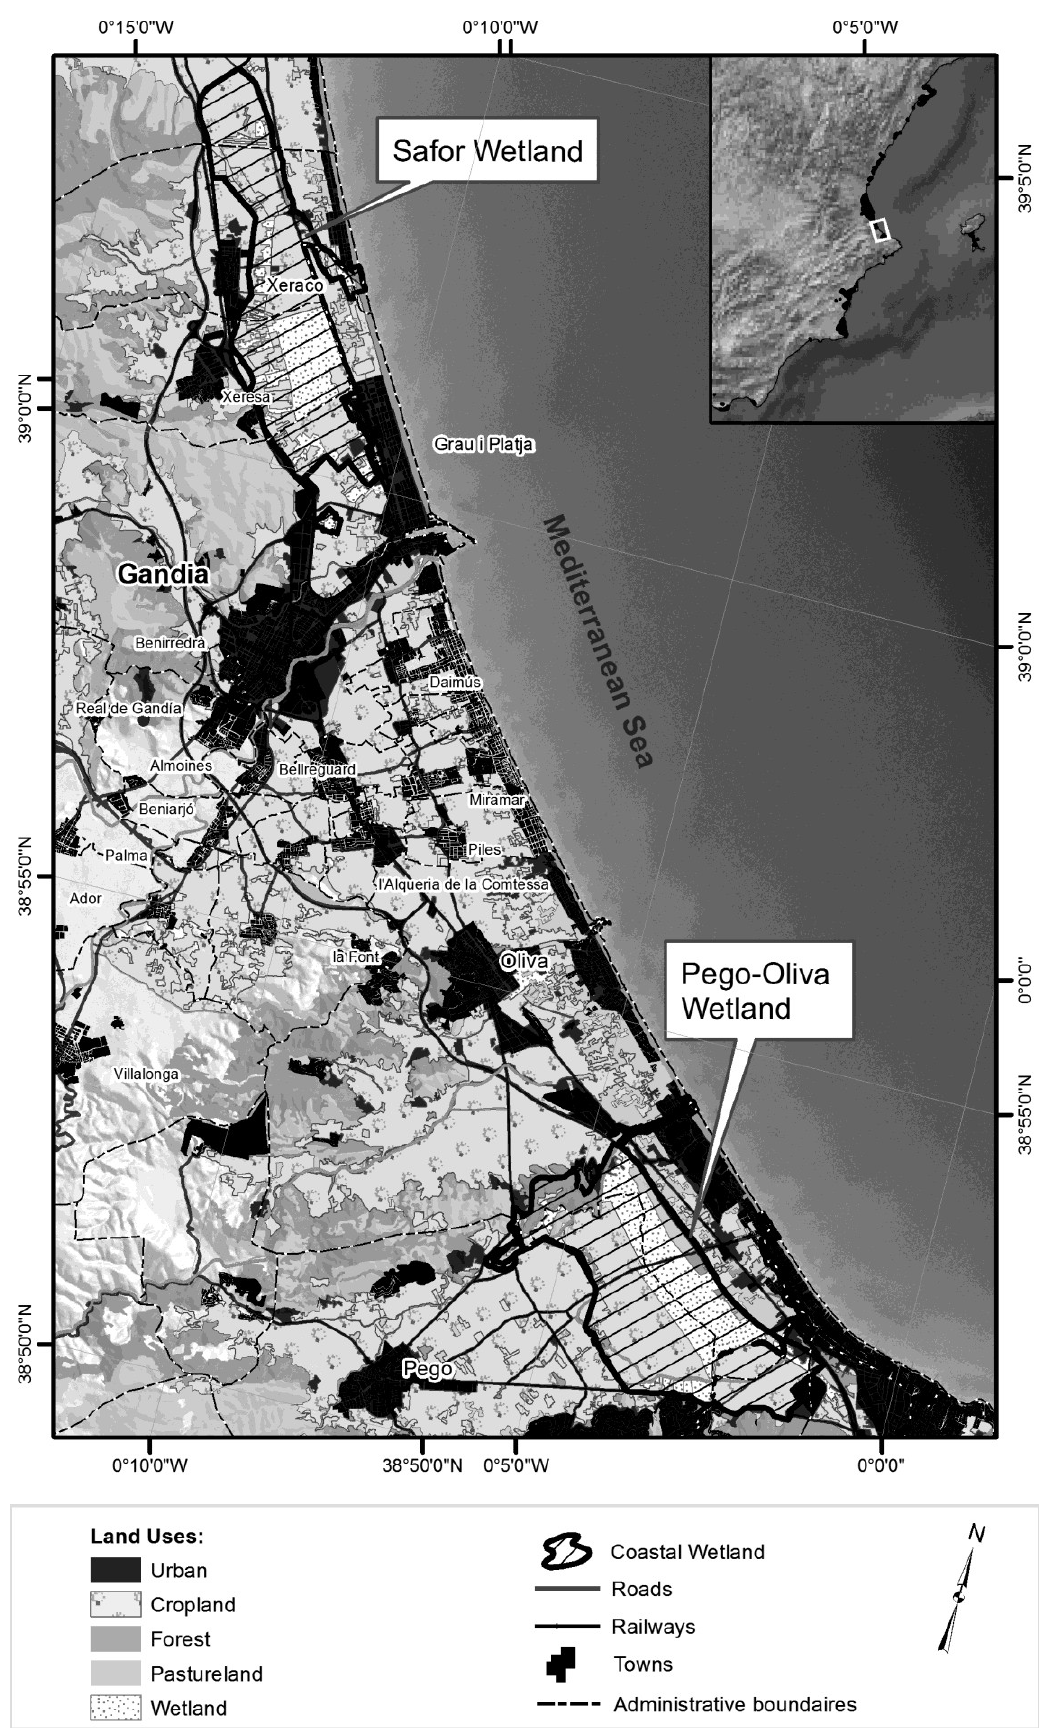
Figure 2. Infrastructures and land uses and in the study